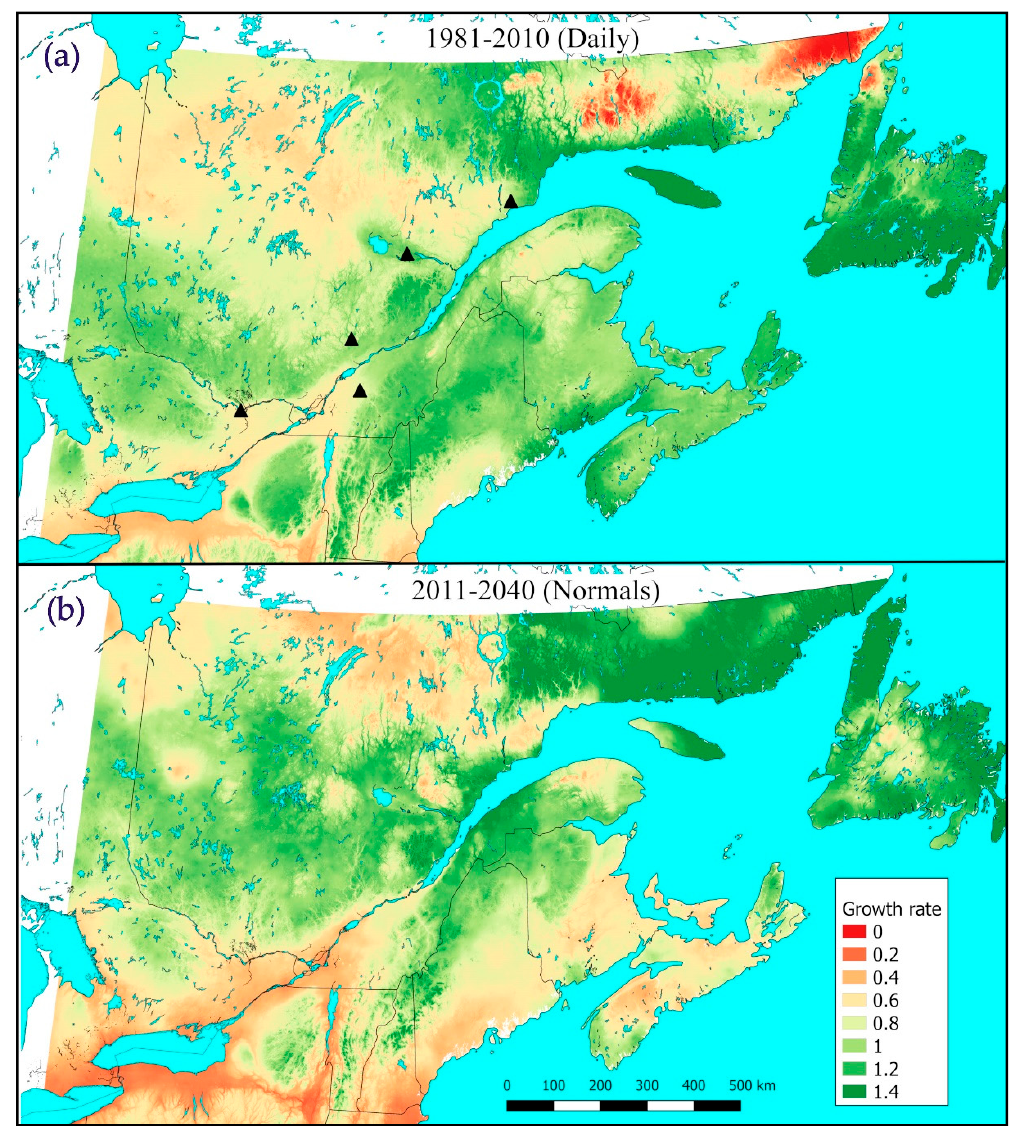
Figure 8. Maps of annual population growth rate of Tranosema rostrale over northeastern North America. ( a ) From 1981–2010 daily minimum and maximum air temperature records. ( b ) From 2011–2040 normals disaggregated to stochastic daily minimum and maximum air temperature, from the Intergovernmental Panel on Climate Change (IPCC)’s greenhouse gas emission scenario RCP 4.5 [53,54]. Triangles in ( a ) are locations of SBW outbreak epicenters.